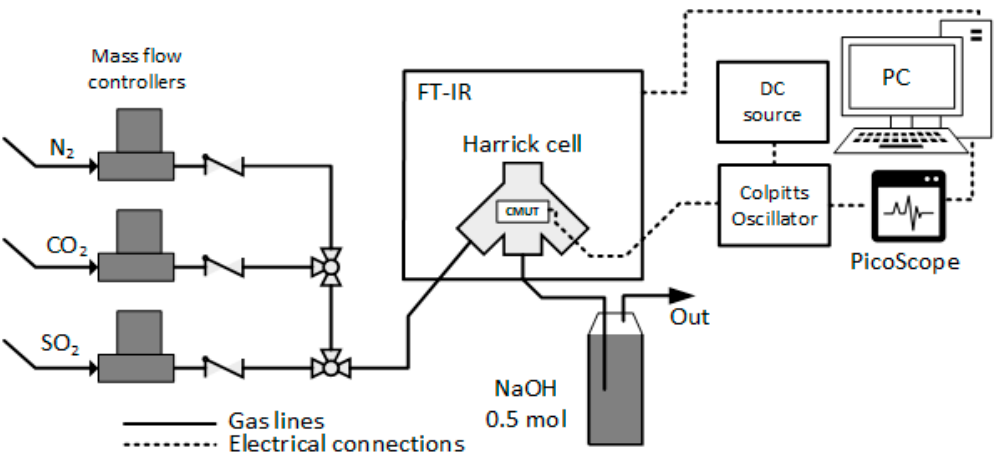
Figure 5. Experimental setup for in-situ simultaneous real-time CMUT resonance frequency and the magnitude of electroacoustic impedance measurement and Fourier transform infrared spectroscopy [59].